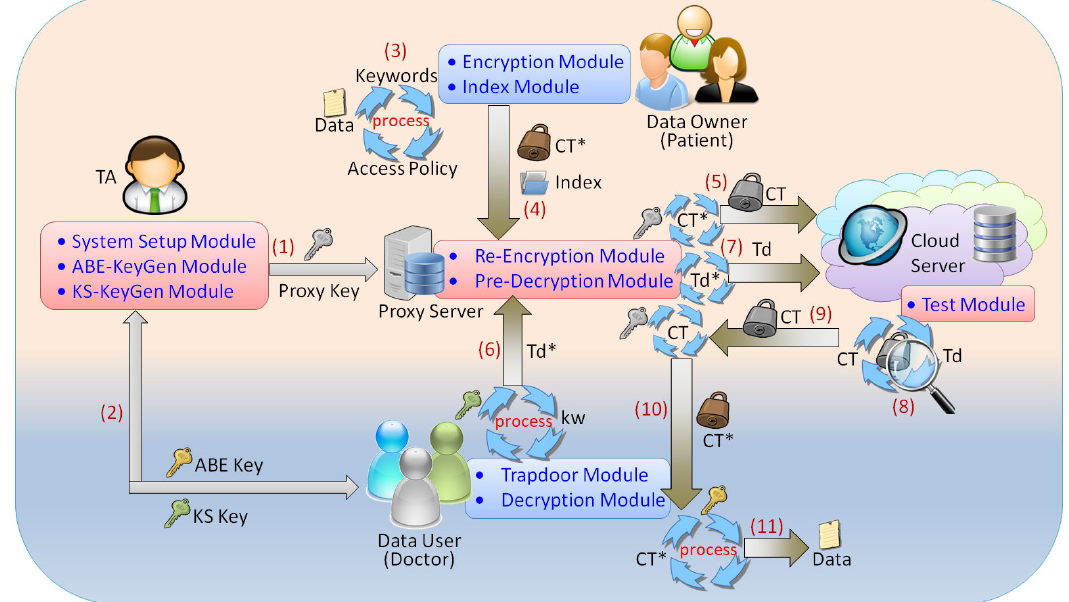
Figure 1. The architecture and data flow of the proposed